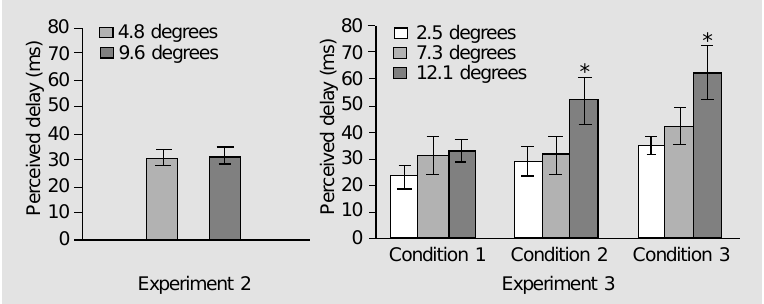
Figure 2. Delay with which the peripheral stimulus was perceived in relation to the central